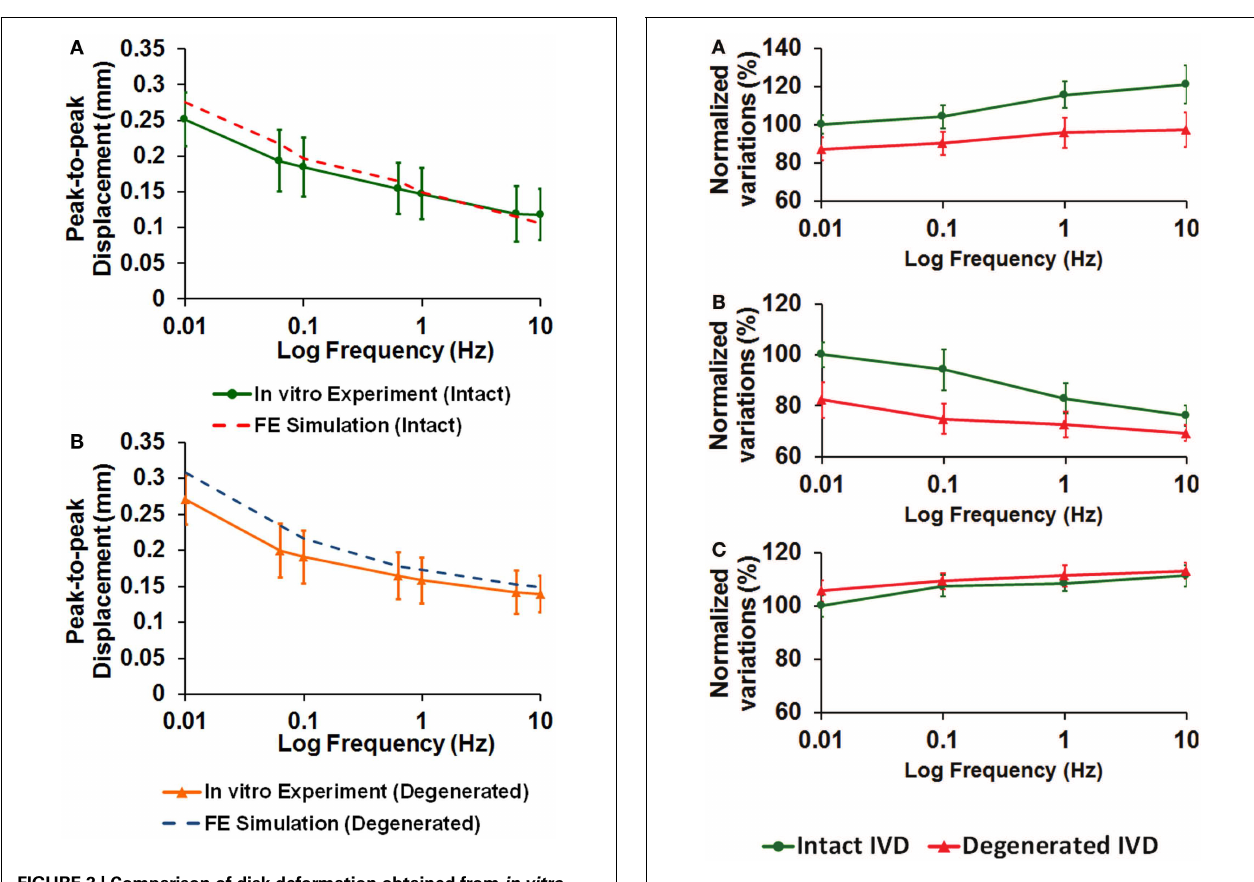
FIGURE 3 |The effect of cyclic loading frequency on the (A) intradiscal pressure (B) total fluid loss (C) axial stress for intact and enzyme-induced degenerative intervertebral disks (the results were normalized to the response of intact disk at 0.01Hz)